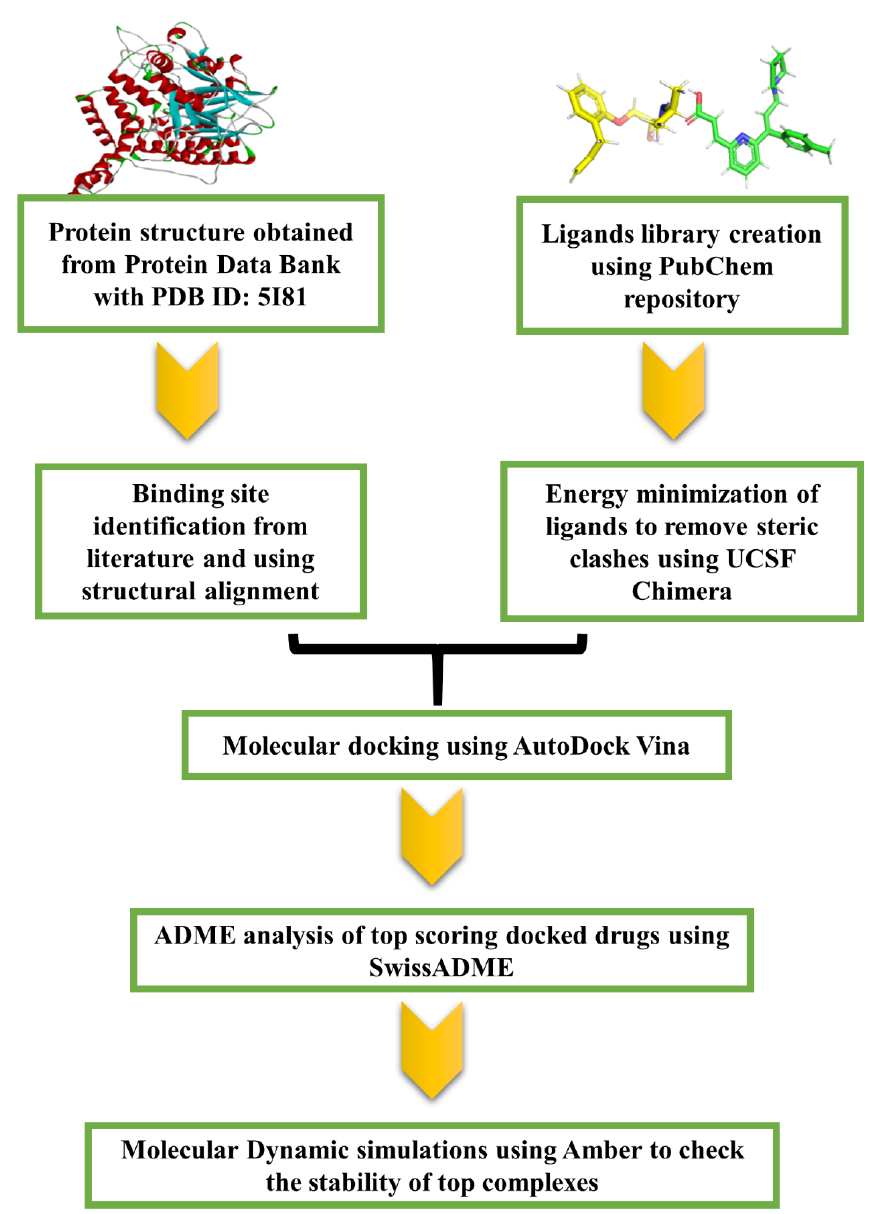
Figure 1. Workflow followed in the present study to identify potential drugs to prevent SARS-CoV-2 infection.